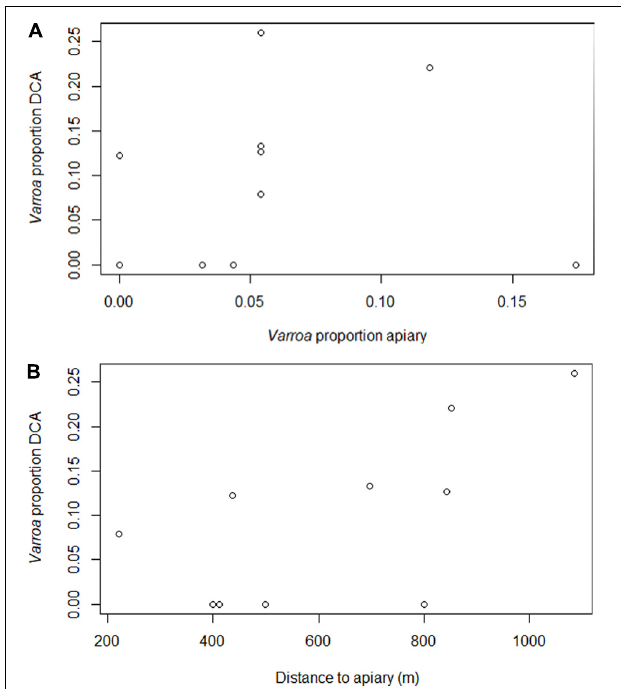
FIGURE 3 | Proportion of Varroa infestation at the DCAs in relation to (A) proportion of Varroa infestation at the closest apiary, and (B) distance to the closest apiary. Data from the two eco-regions of Argentina were included in the analysis. Proportion of Varroa infestation was arcsine-square